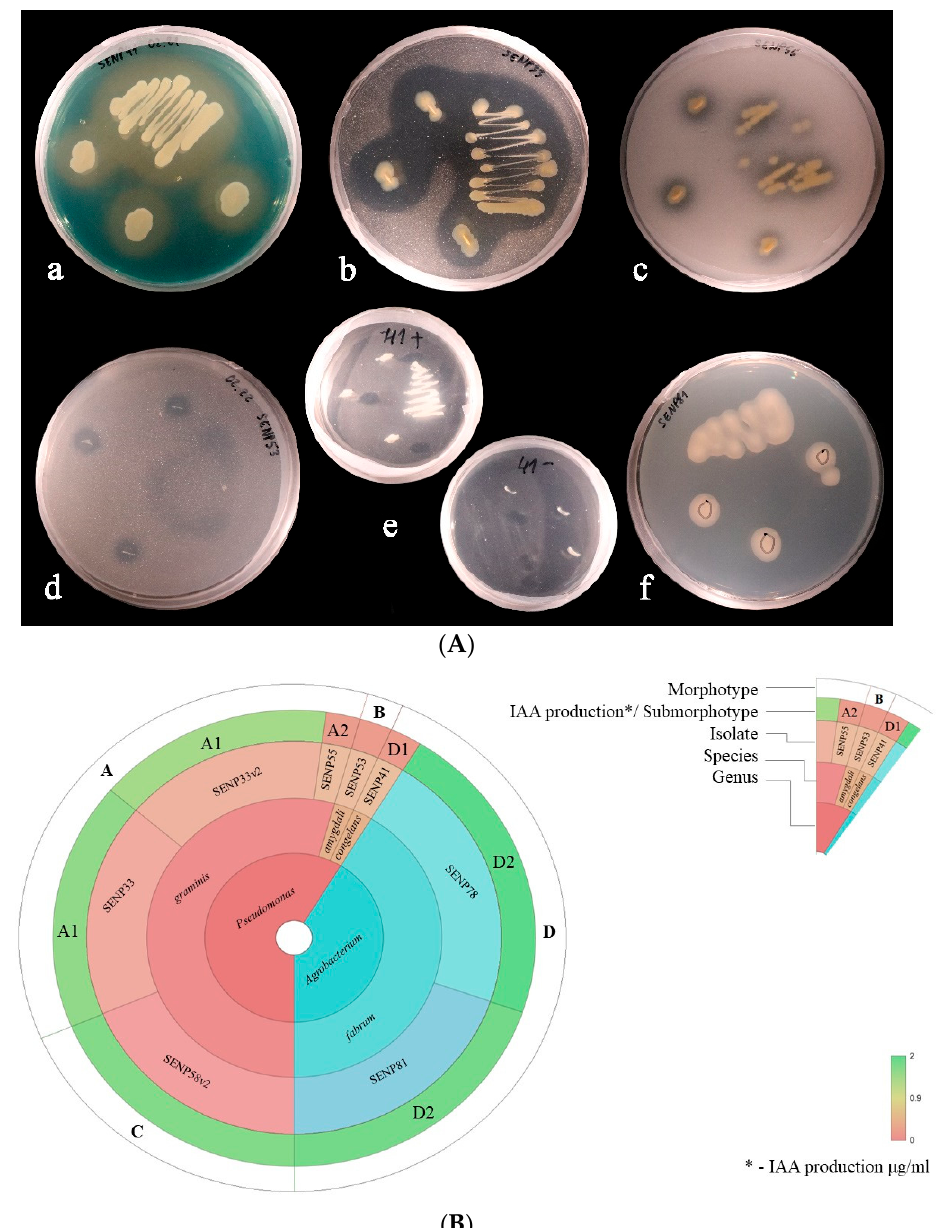
Figure 4. Plant growth promoting traits of the bacterial isolates. ( A ). Representative plant growth promoting trait tests on selective media: (a) siderophore production by SENP41 (a color change in the medium from blue to yellow), (b) phosphate mineralization by SENP33 (a clear zone around the colonies), (c) phosphate solubilization by SENP55 (clear zones around the colonies), (d) potassium solubilization by SENP53 (clear zones around the colonies), (e) ACC deaminase activity by SENP41 (growth on the medium with ACC as the only nitrogen source and no growth on the negative control plate without any nitrogen), and (f) nitrogen fixation by SENP81 (growth on the medium without any nitrogen source). ( B ). Identification of endophytic bacteria morphotypes based on IAA production. Starting from the middle of the circle, the isolates were separated by genus, species, and isolate according to the amount of IAA produced. The penultimate circle indicates the sub-morphotype of the species, and the color differs according to their IAA production ( μ g/mL). The outside circle indicates the morphotype of the isolates.